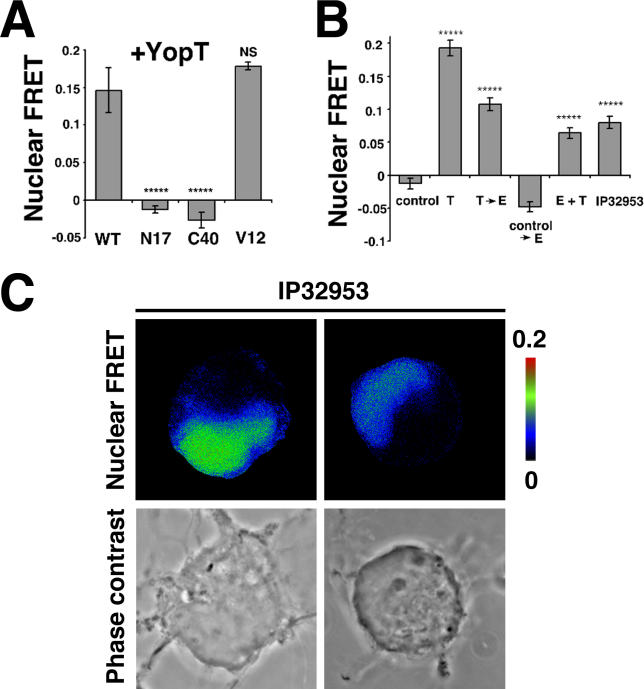
Nuclear Localization of Rac1 Protects It from Inactivation by YopECOS1 cells expressing the probes for Rac1 activity (mCFP-Rac1 and mYFP-PBD) were challenged with the indicated strains and then analyzed for nuclear-localized Rac1 activation using FRET. To account for differences in PBD and Rac1 concentrations in the nucleus relative to the cytoplasm, FRET was normalized to both proteins (Materials and Methods).(A) The FRET readout in the nucleus requires Rac1 activation. Translocation of various mutants of mCFP-Rac1 was promoted by incubating COS1 cells with YP17/pYopT2 for 30 min.(B) YopE is not able to reverse or prevent the accumulation of active nuclear Rac1 promoted by YopT. Control, 30-min incubation with YP17 (yopE −yopT −); Control → E, 30-min incubation with YP17 (yopE −yopT −) followed by 30-min incubation withYP15 (yopE +yopT −); E + T, 30-min coinfection withYP15 (yopE +yopT −) and YP17/pYopT2 (yopT +yopE −); T, 30-min incubation with YP17/pYopT2 (yopT +yopE −); and T → E, 30-min incubation with YP17/pYopT2 (yopE −) followed by 30-min incubation withYP15 (yopE +yopT −). ***** p < 5 × 10−5 relative to control incubation.(C) IP32953 inactivates cytosolic Rac1 and activates nuclear Rac1. Two examples of cells infected with IP32953 for 1 h show intense Rac1 activity (displayed as Nuclear FRET) that corresponds to the nucleus shown in phase contrast images.